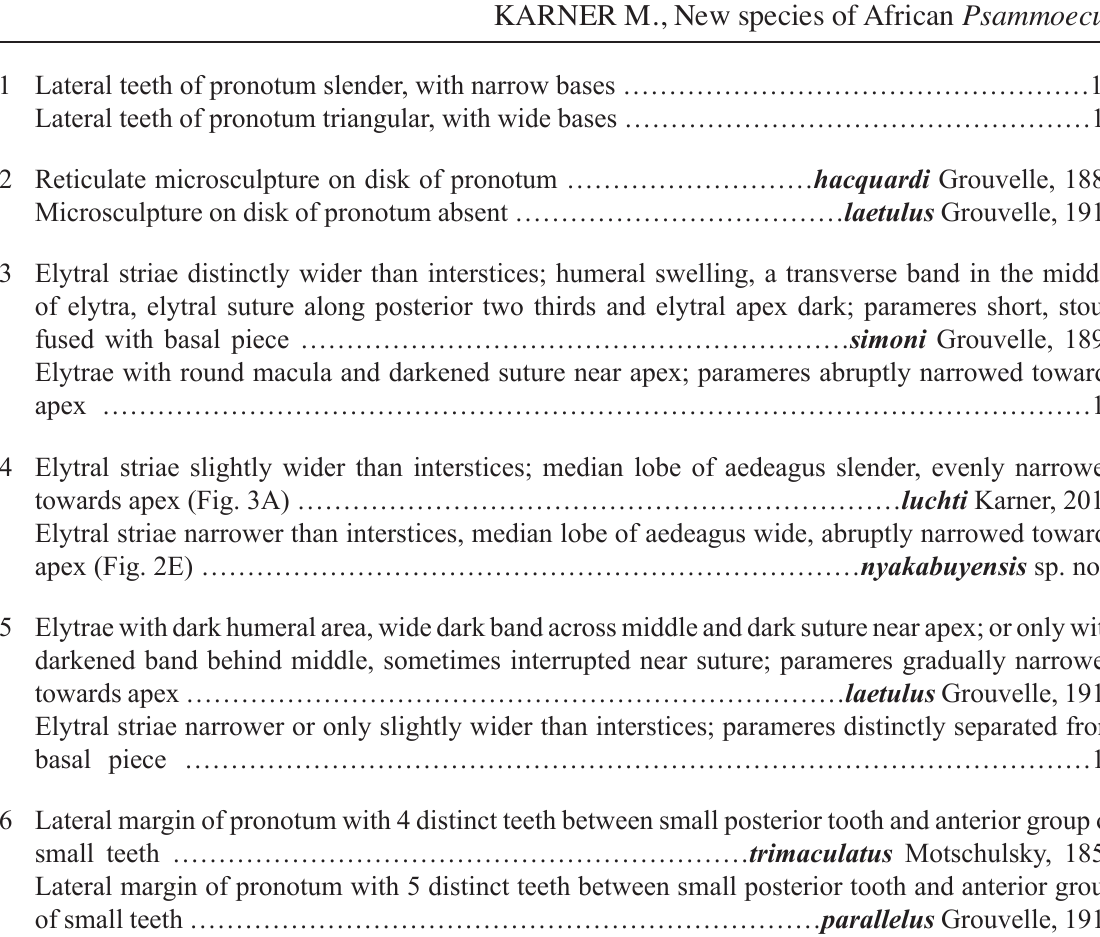
Lateral margin of pronotum with 5 distinct teeth between small posterior tooth and anterior